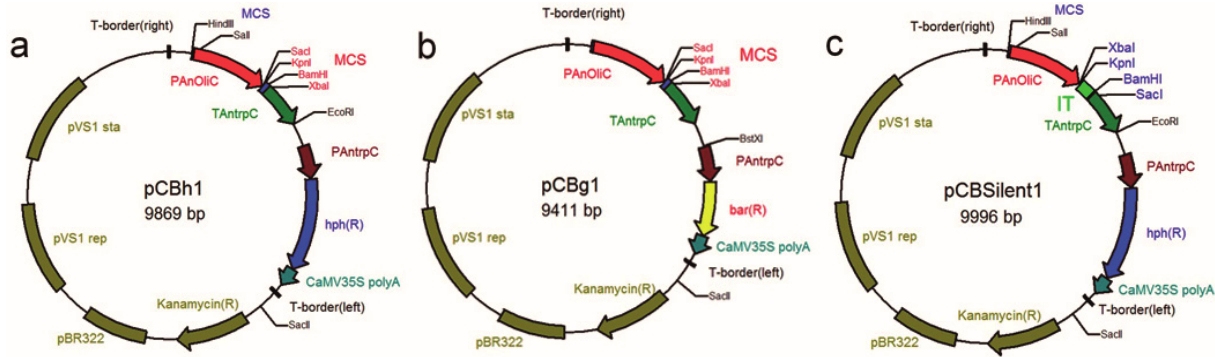
Figure 6. Schematic structures of the Agrobacterium vectors. ( a ) The expression